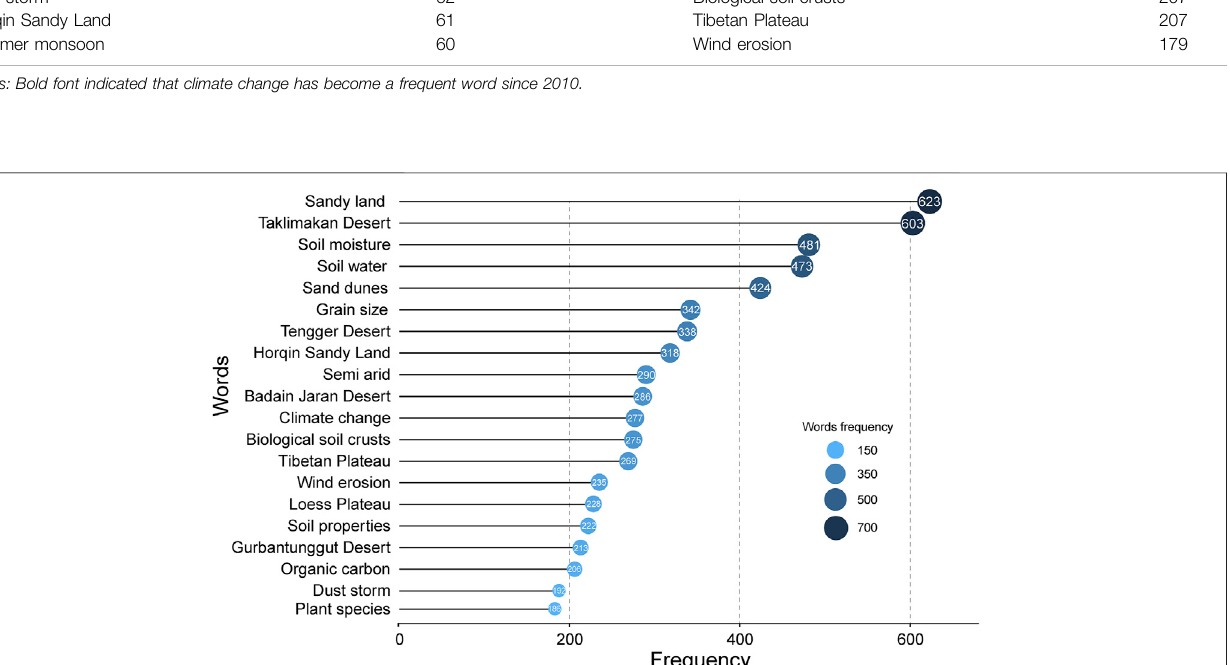
Frontiers in Earth Science |